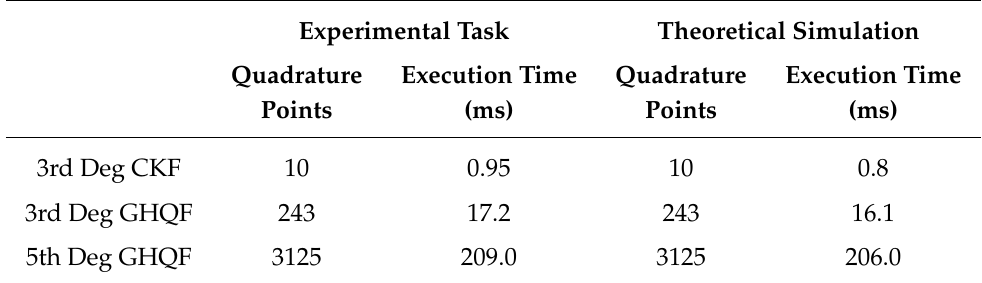
Table 3. Comparative of quadrature points and execution time during implementation of the experi- mental task and theoretical simulations. Experimental Task Theoretical Simulation